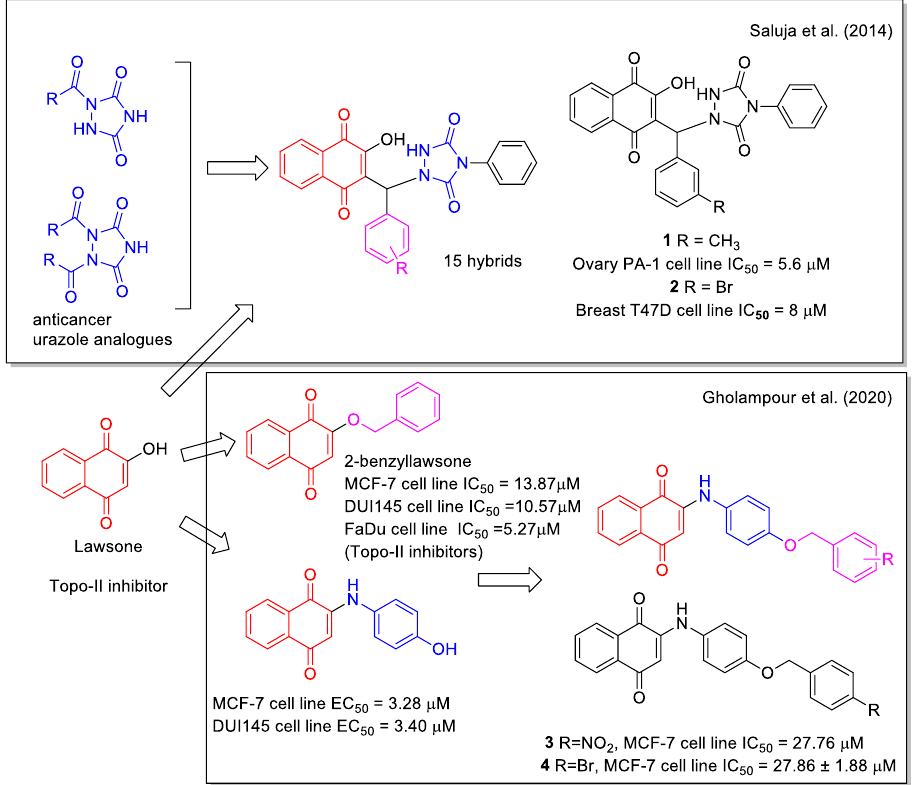
Figure 3. 1,4-Naphthoquinone-urazole hybrids as reported by Saluja et al. [26] and arylaminonaph- toquinone hybrids as reported by Gholampour et al.